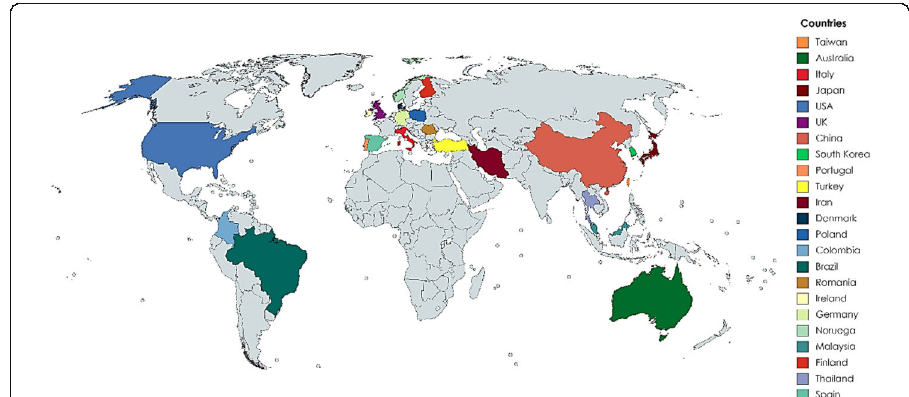
Fig. 4 Distribution of textual corpus authors by country